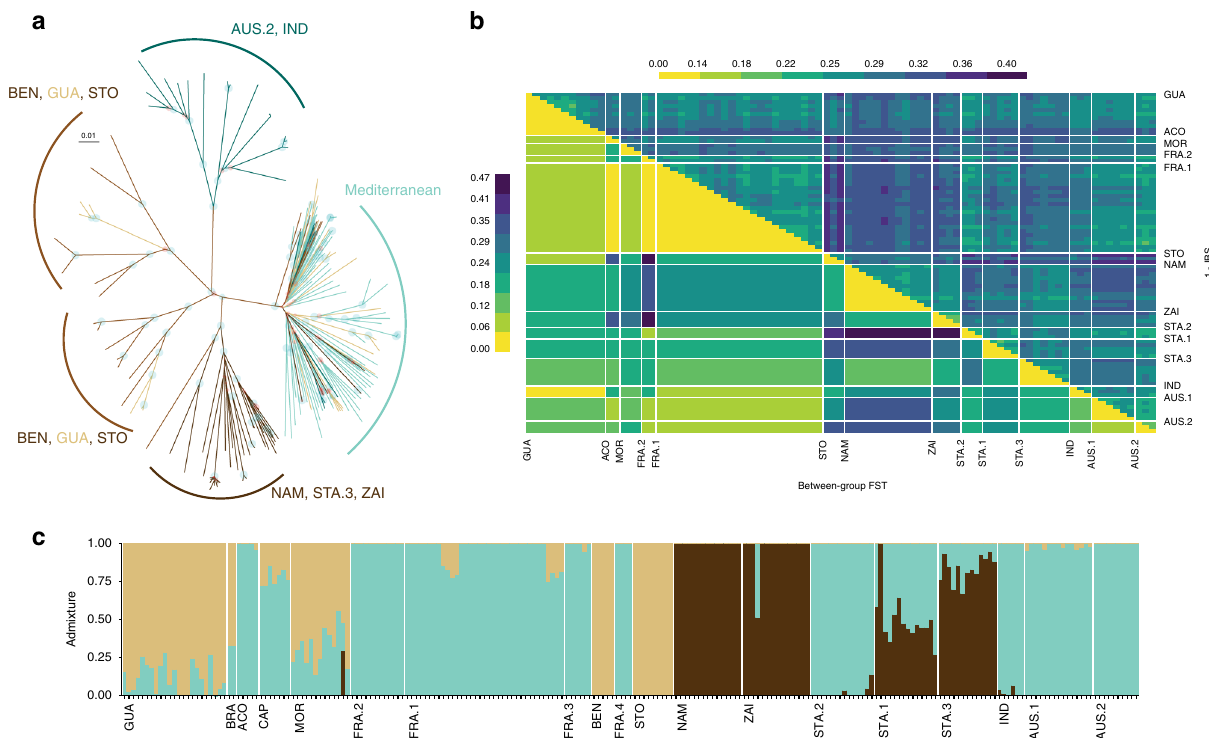
Fig. 3 Global connectivity of Haemonchus contortus isolates. a Unrooted maximum likelihood phylogenetic tree of 223 mitogenomes. The tree was constructed using 3052 SNPs from 223 individual mitochondrial genomes. Circles indicate bootstrap support for each node, blue if support was higher than 70%, red elsewhere. Branches leading to a sample identi fi er are coloured by geographic region described in Fig. 1. Mitogroups are annotated with constitutive sample populations. b Genetic dissimilarity and divergence among isolates. The matrix shows pairwise dissimilarity between individuals (upper right) and pairwise F ST between isolates (lower left). c Admixture analysis of 223 individuals. A cluster size of K = 3 is presented, determined from sites with minor allele frequency above 5% and call rate higher than 50%. Admixture pattern for other values of K is provided in Supplementary Figs. 5. Isolates are presented sorted along their longitudinal range, and samples sorted by assignment to the three coloured